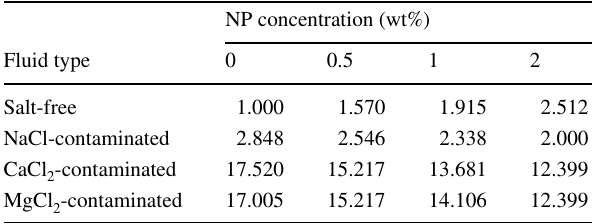
Table 5 Permeability ratio of the studied fluids NP concentration